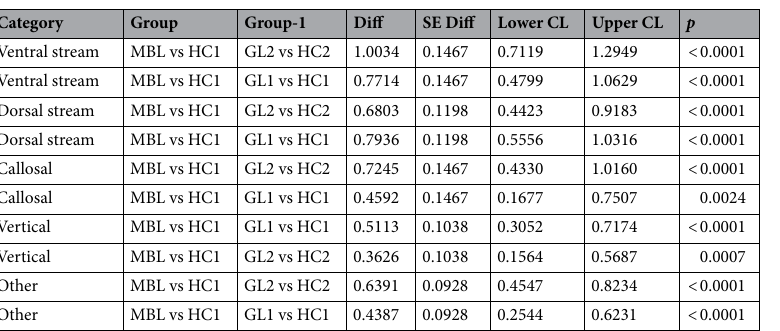
Table 5. Significant differences between groups per category based on the effect size of fractional anisotropy. Results of the post hoc analysis using Tukey HSD to determine which tract categories differed between group comparisons based on the g estimates of fractional